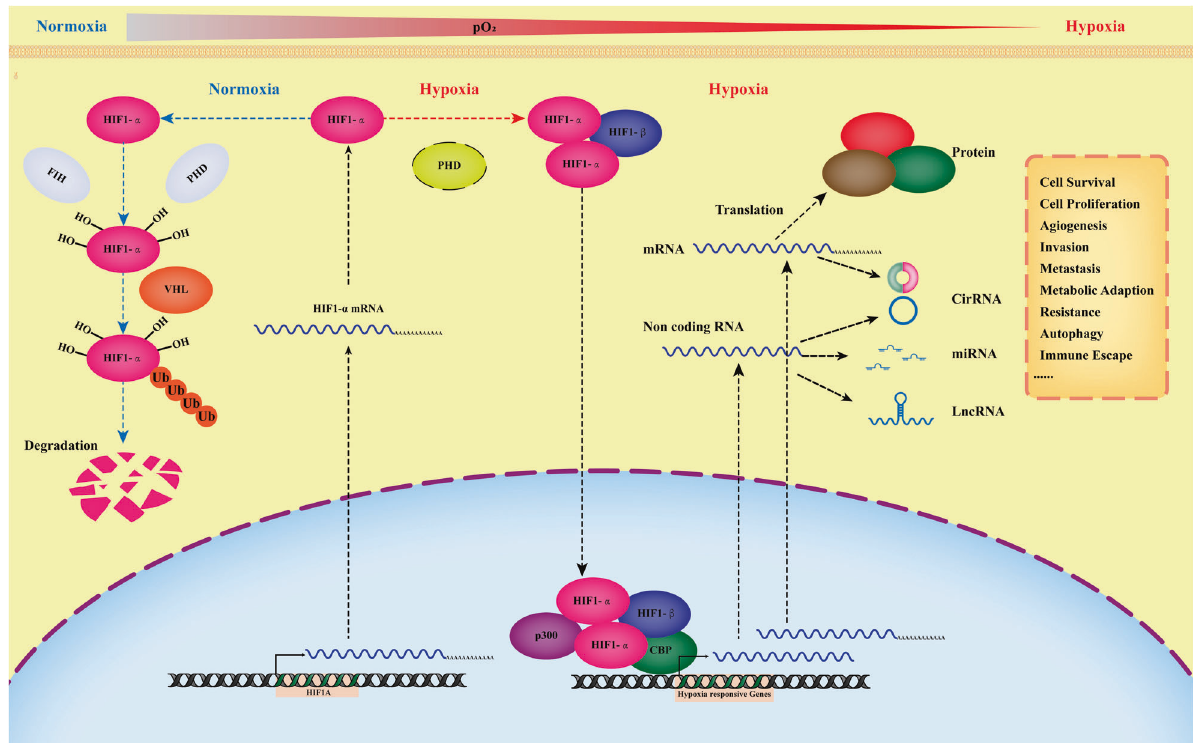
Fig. 1 HIF-1 α activates downstream coding and non-coding genes transcription in response to hypoxia. Under normoxic conditions, HIF- 1 α subunits are hydeoxylated by prolyl hydroxylase domain proteins (PHDs) and other prolyl hydroxylases. Hydroxylated HIF-1 α subunits are recognized by von Hippel – Lindau (VHL) proteins that target HIF-1 α for subsequent ubiquitination and proteasomal degradation. During hypoxia, the hydroxylation reactions are reduced, resulting in HIF-1 α accumulation, dimerization with HIF-1 β , binding to target genes and activation of such genes via recruitment of p300/CBP and formation of the transcription initiation complex that mediates various hypoxic responses of